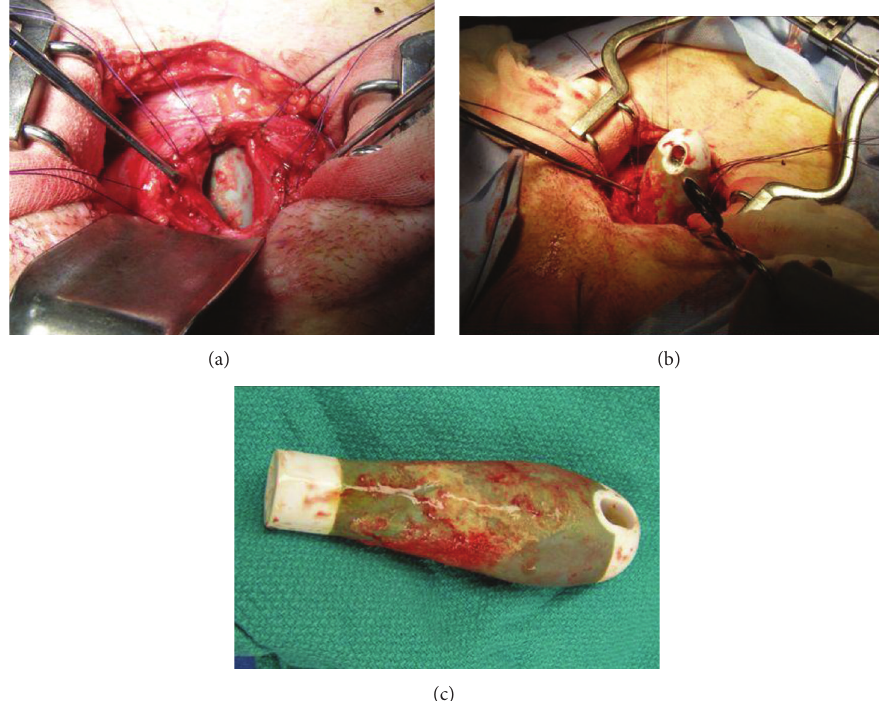
Figure 3: The toilet brush handle exposed through the cystotomy (a), partially extracted (b), and removed (c).